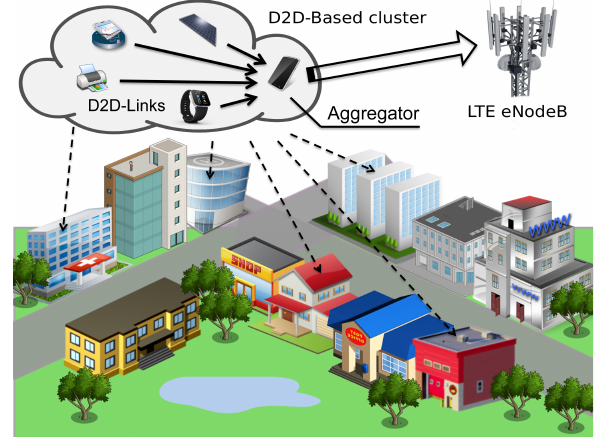
Figure 1. Reference scenario IoT data collection in an LTE-A cellular